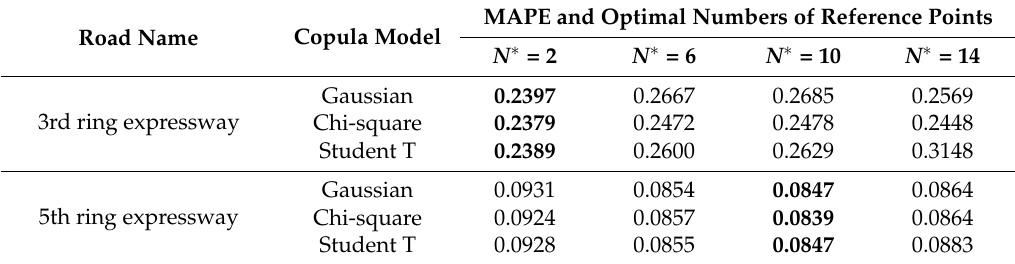
Table 4. Performance of copula models based on MAPE at 8:00 (timestamp = 240) on 1 June 2015. MAPE and Optimal Numbers of Reference Road Name Copula Model